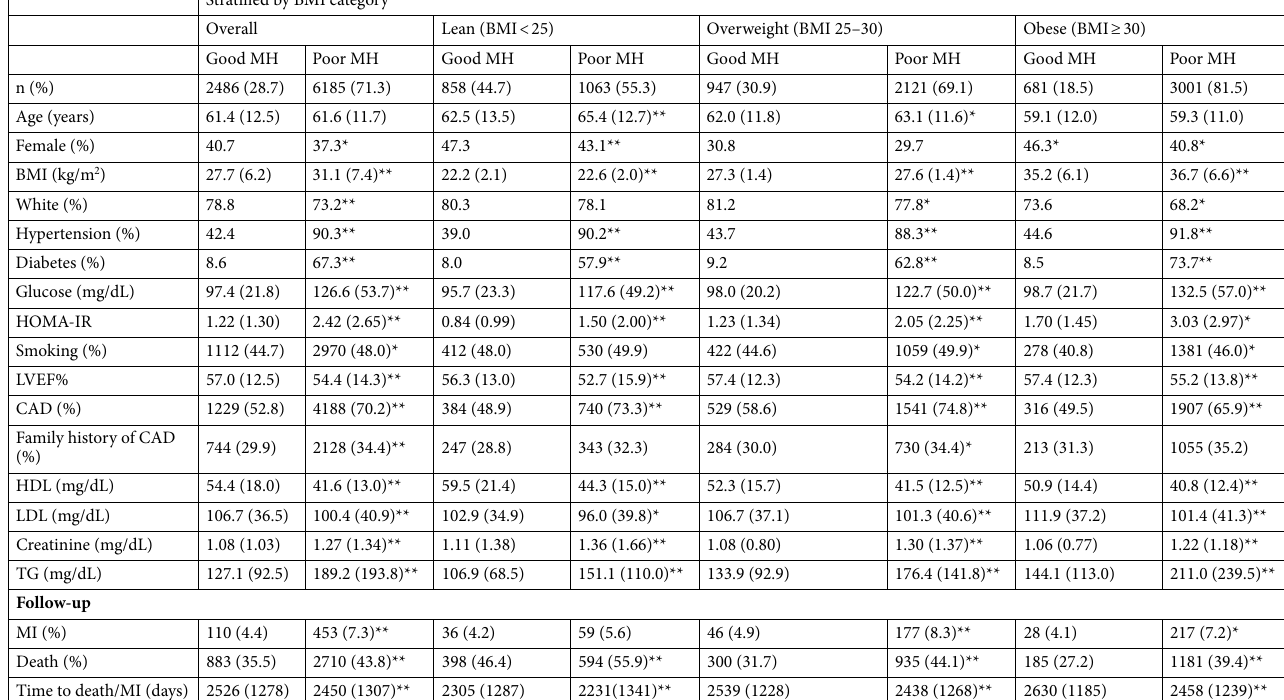
Table 1. Baseline characteristics of the CATHGEN study population stratified by traditionally defined MH and BMI category. * p < 0.05, ** p < 0.001 for comparison to good MH. All continuous variables reported